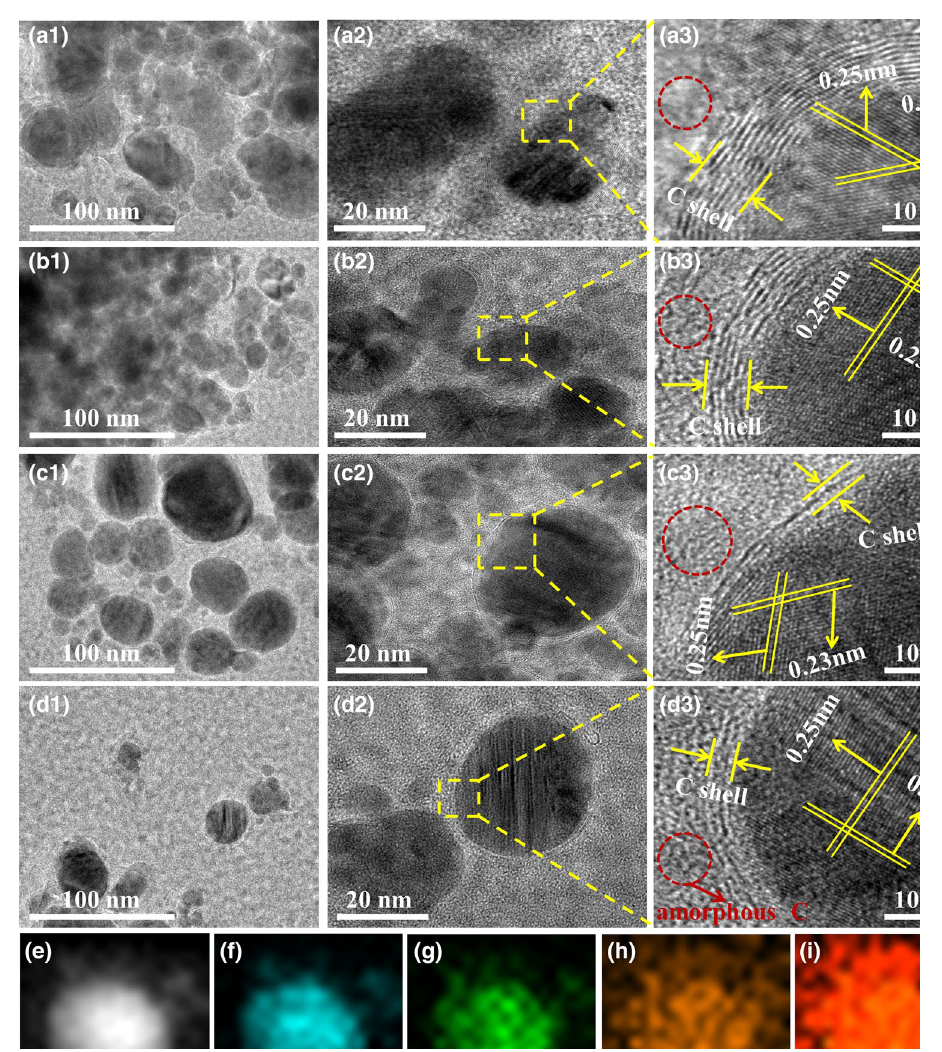
Fig. 2 TEM and high resolution TEM images: a1 – a3 FMCA-1, b1 – b3 FMCA-2, c1 – c3 FMCA-3, and d1 – d3 FMCA-4. HAADF-STEM images of e single Fe/MnO nanocrystal and f – i elemental mapping